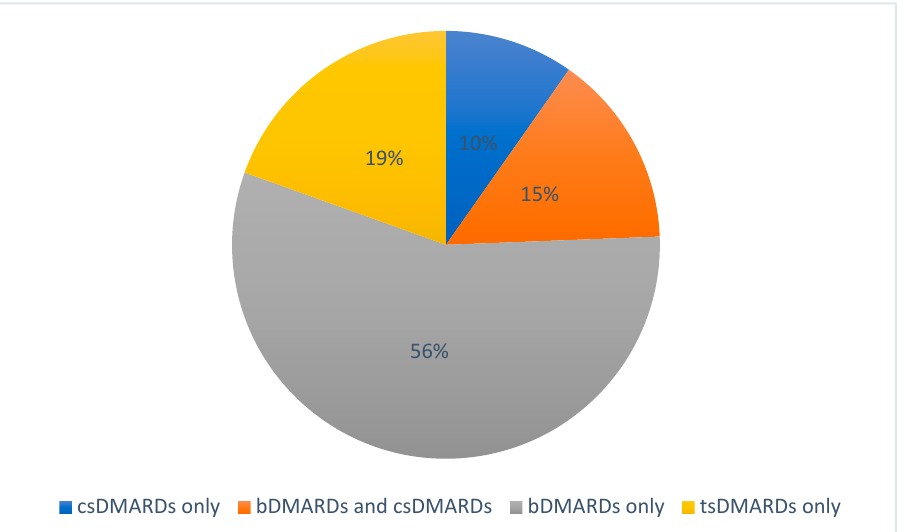
Figure 2. Proportions of DMARD agents involved in registered studies.